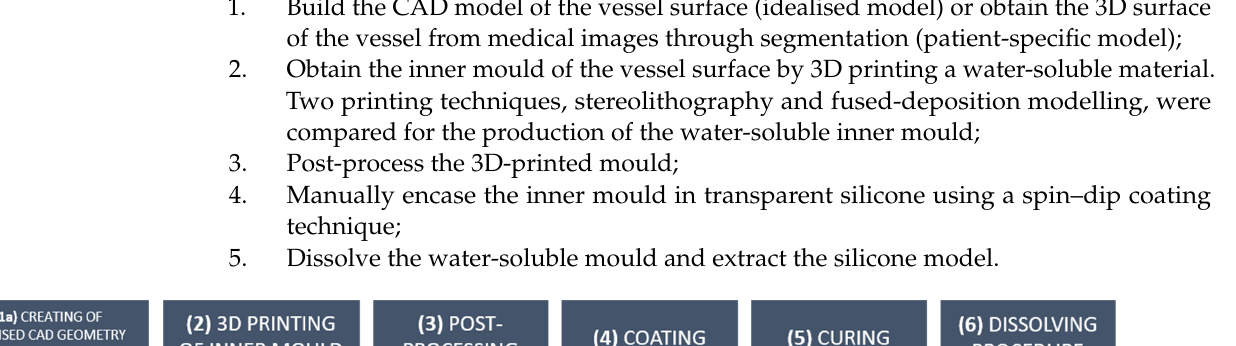
Figure 1. The proposed manufacturing process: ( 1a ) acquisition of patient-specific clinical images and segmentation to reconstruct the vasculature geometry; ( 1b ) creation of the CAD simplified ge- ometry; ( 2 ) 3D printing of the vessel inner mould in water-soluble material; ( 3 ) physical model re- finement (removal of 3D printing supports, polishing); ( 4 ) spin–dip coating and ( 5 ) curing; and ( 6 ) dissolving procedure in a hot water bath.